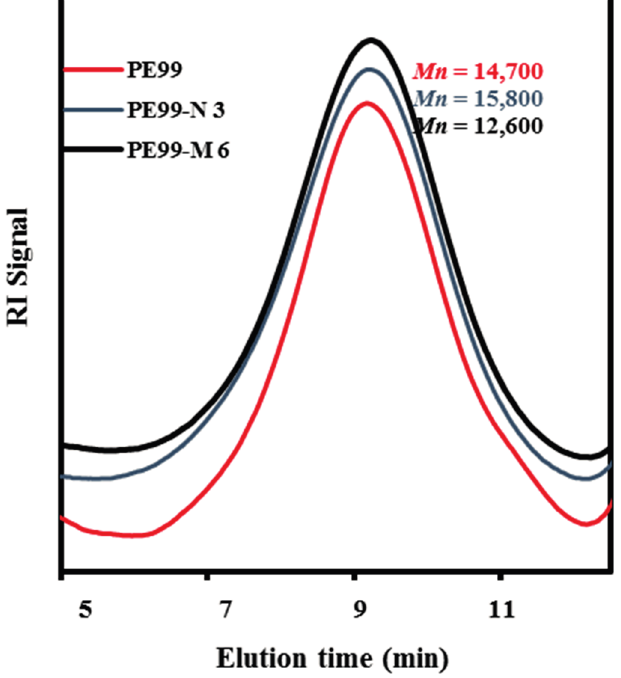
Figure 6. GPC molecular weight distribution curves determined for micro-molded PE99, PE-N 3, and PE99-M 6